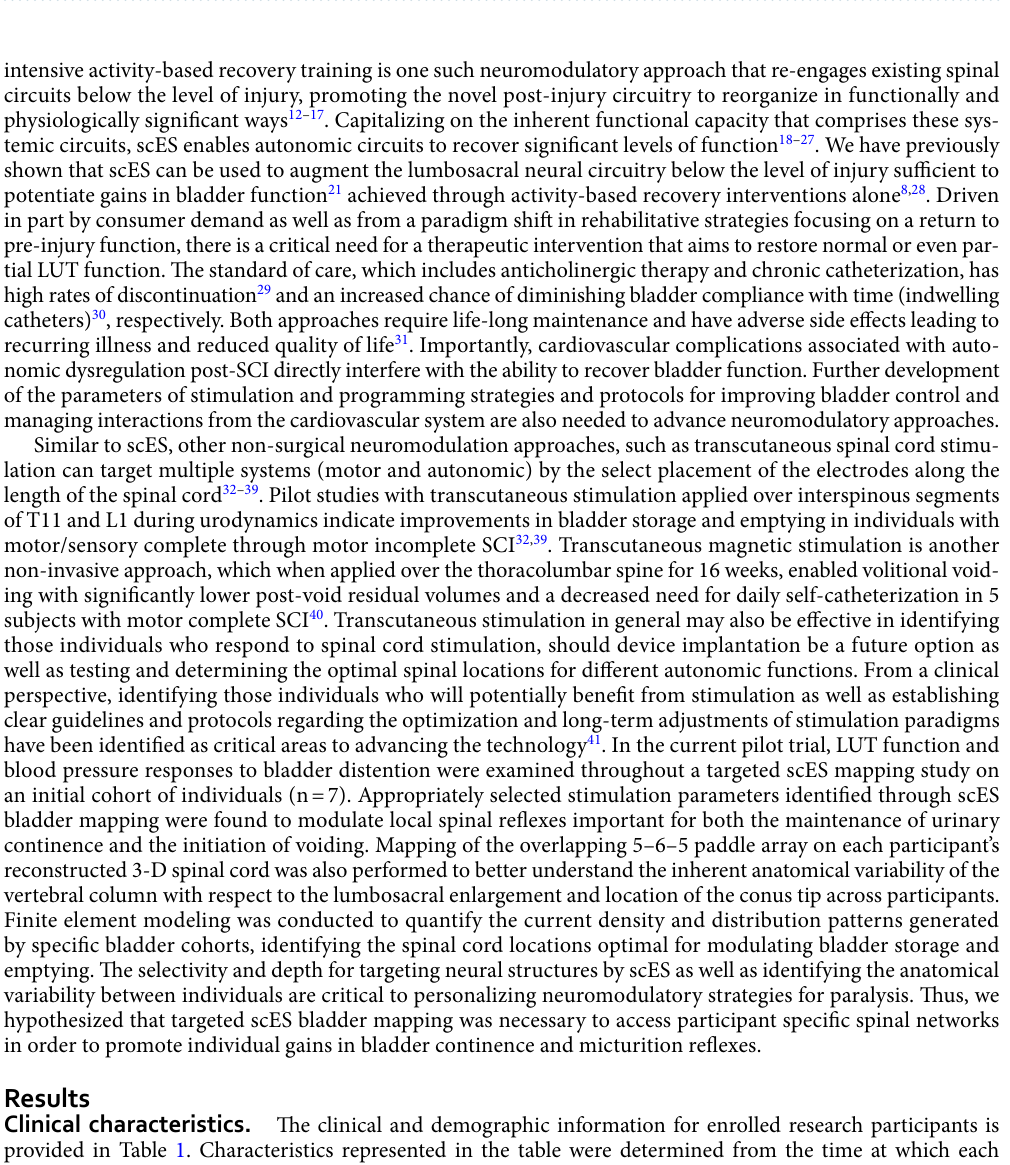
Table 1. Participant characteristics. AIS American Spinal Injury Association Impairment Scale, CIC clean intermittent catheterization, SP suprapubic